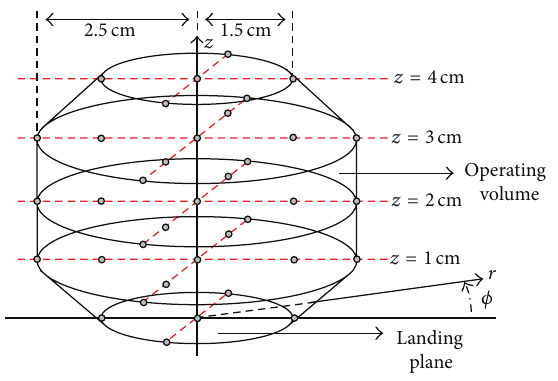
Figure 8: Operating volume for the EMV